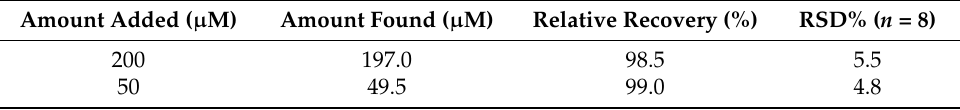
Table 2. Standard deviations and recoveries of naproxen from spiked urine